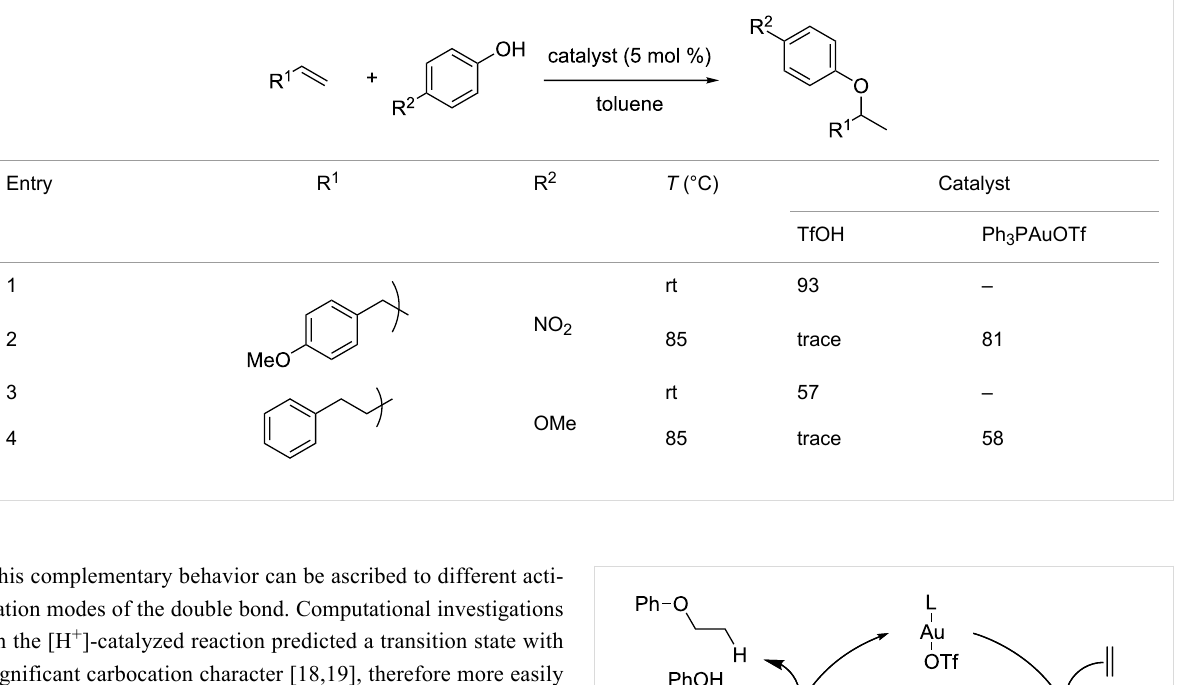
Table 1: Comparison of the catalytic activity of TfOH and PPh 3 AuOTf in the addition of phenols to alkenes.